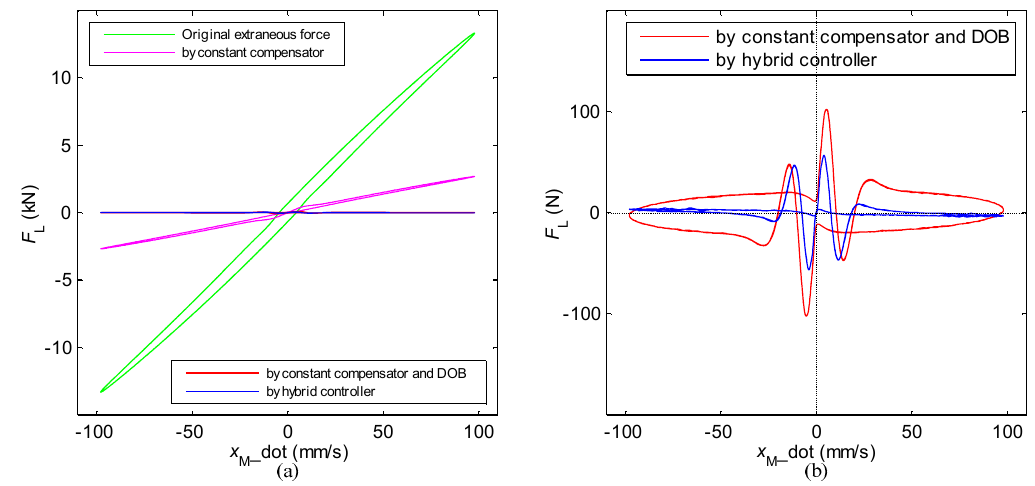
F – x M with disturbance 7sin14 t (mm/s), ( a ) comparative results L M